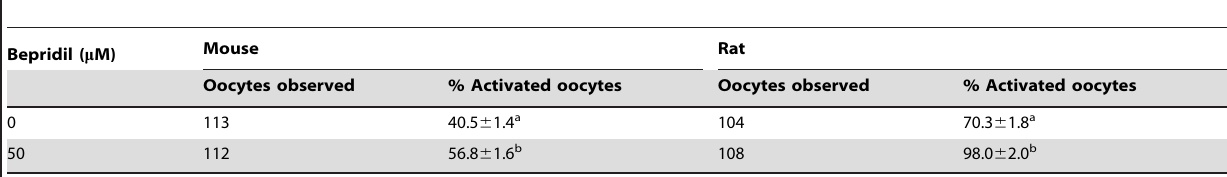
Table 3. Activation rates after mouse or rat oocytes collected 19 h post hCG were cultured for 6 h in CZB (mouse) or mR1ECM (rat) medium supplemented with or without